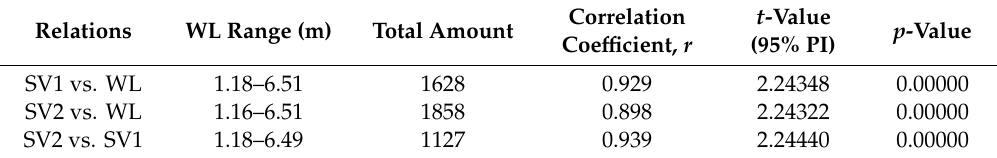
Table 1. Characteristics of samples selected from 2012–2014 at Wulilin Bridge.